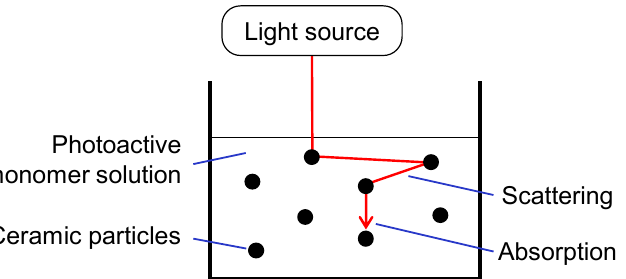
Figure 1. Schematic representation of the scattering phenomenon occurring when a ceramic slurry is invested by photons.